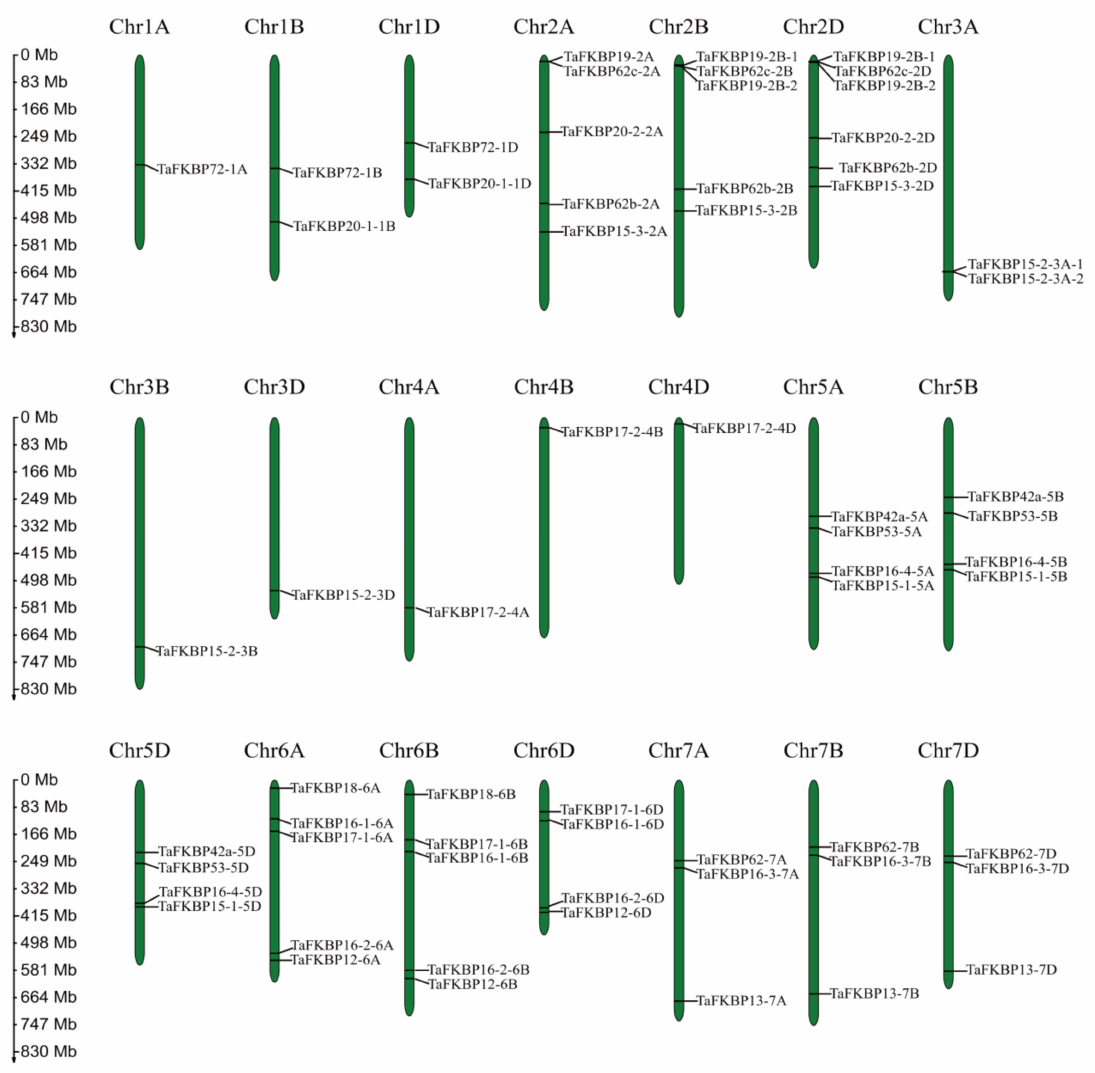
Figure 2. Chromosomal distribution of TaFKBP genes. Each TaFKBP was mapped to its chromosomal position by its physical positions of wheat genomes. The chromosome number is labeled at the top of each chromosome. The scale bar is in mega bases